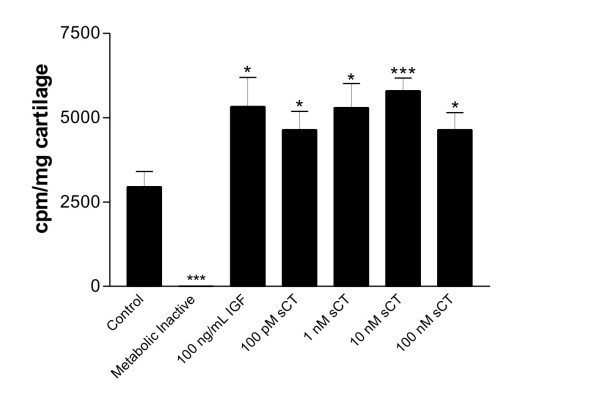
Calcitonin stimulates proteoglycan formation in human osteoarthritic cartilage. Human OA articular cartilage explants were cultured with or without doses of salmon calcitonin, and on day 16 pulsed with 5 μCi 35SO4 for 24 hours. The proteoglycans were extracted and the incorporation of 35SO4 were followed by liquid scitillation counting. Insulin-like growth factor (IGF) was used as a positive control to induce formation in articular cartilage. The bars represent the mean value of count pr. minute, cpm, from 6-replicates and the indivdual values were adjusted for the amount of cultured cartilage. The errorbars are the standard error of mean, SEM. The asterisks symbolize the levels of statistical difference to the vehicle control, * P < 0.05, ***P < 0.001.